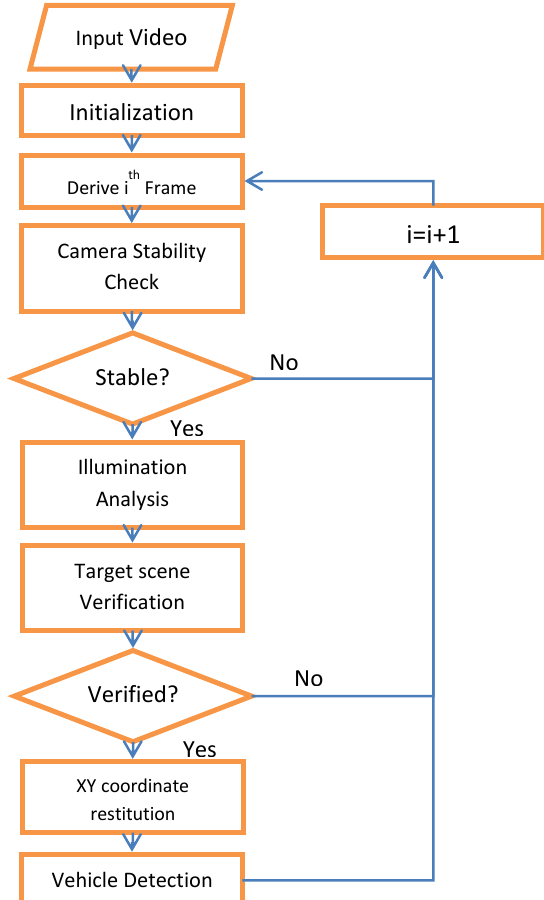
Figure 1: The flowchart of general processing of the algorithm.